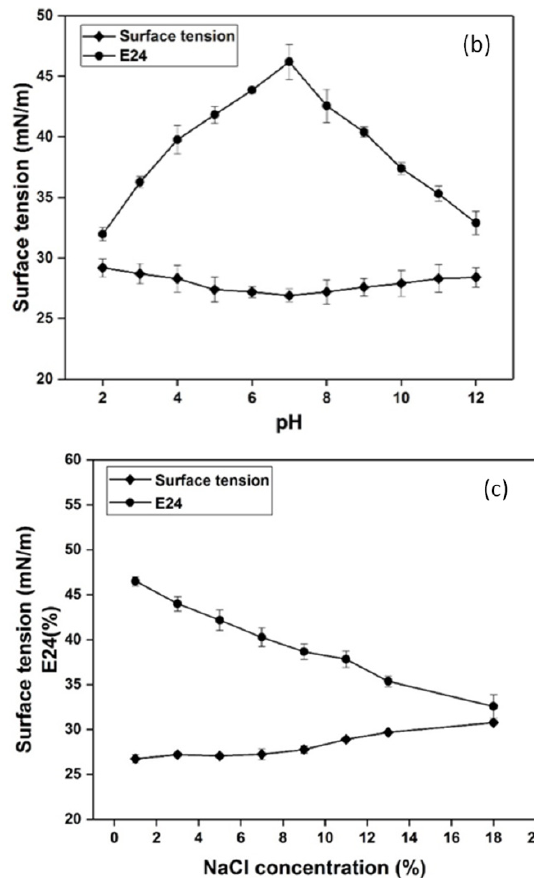
Figure 6. Effect of temperature ( a ), pH ( b ) and NaCl concentration ( c ) on the surface tension and emulsifying property (E 24 ) of XW-1 biosurfactant.